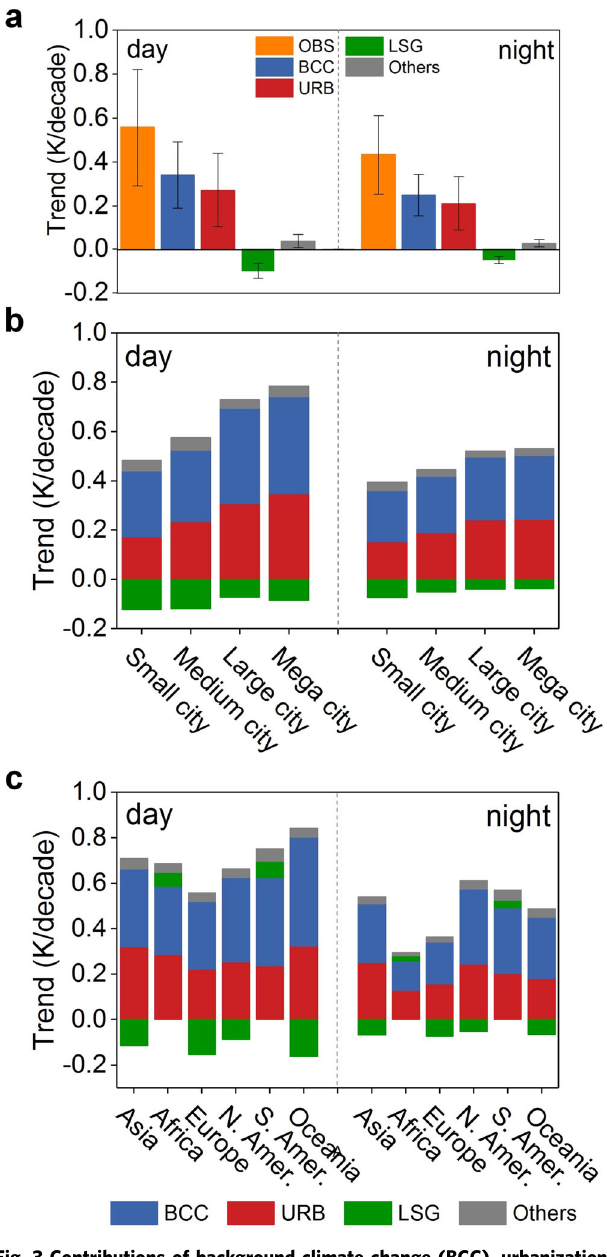
Fig. 3 Contributions of background climate change (BCC), urbanization (URB), and landscape greening (LSG) to observed urban surface warming trends (OBS). Mean contributions across the globe ( a ), mean contributions by city size ( b ), and mean contributions by continent ( c ). Error bars are ±1 S.D. Note that “ Others ” represents the residual component that cannot be explained by these three selected parameters. Note that the error bars represent 10%~90%